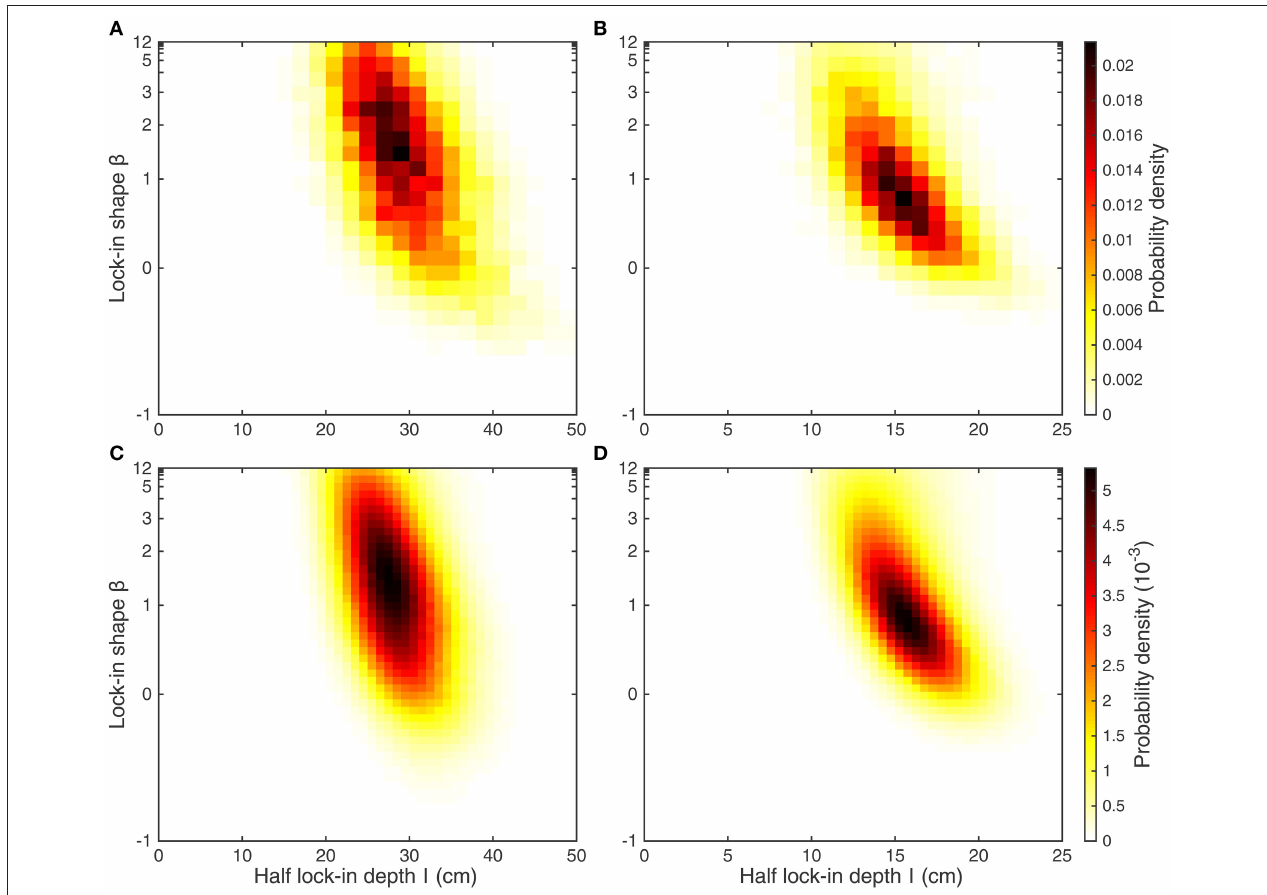
FIGURE 6 | The posterior distribution of lock-in parameters for (A) Gyltigesjön and (B) Kälksjön derived from age-depth models based on both paleomagnetic and radiocarbon data, compared to (C,D) reanalyzed results of Mellström et al. (2015), based on binned paleomagnetic data and wiggle-match dated